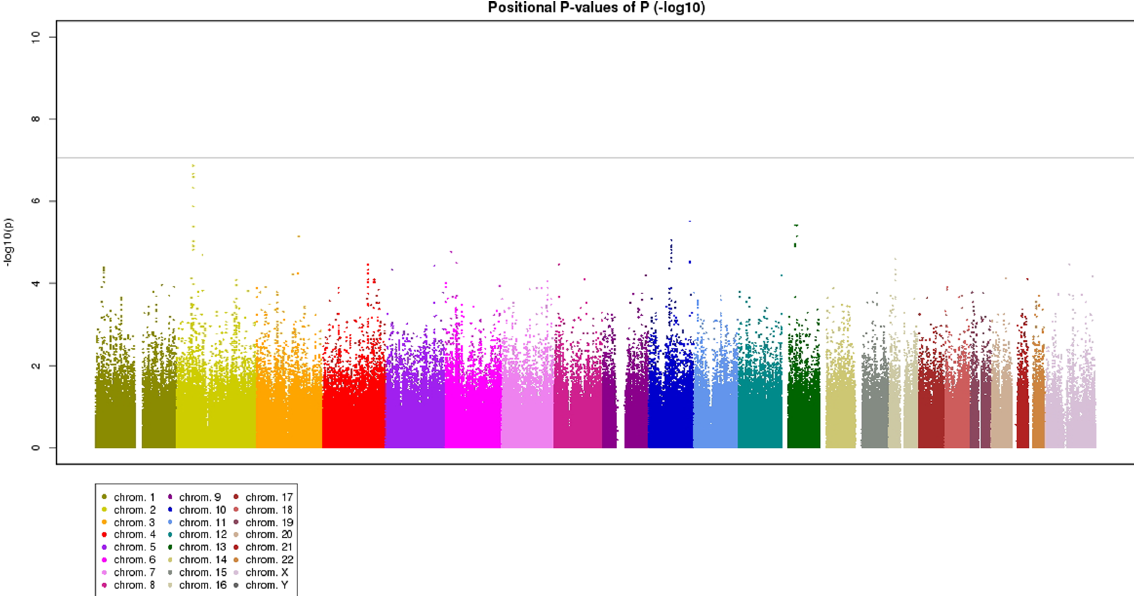
Figure 1. Minus log-transformed P-values are shown in a signal intensity (Manhattan) plot relative to their genomic position for bilaterality of age-related macular degeneration. P-values are adjusted for age and